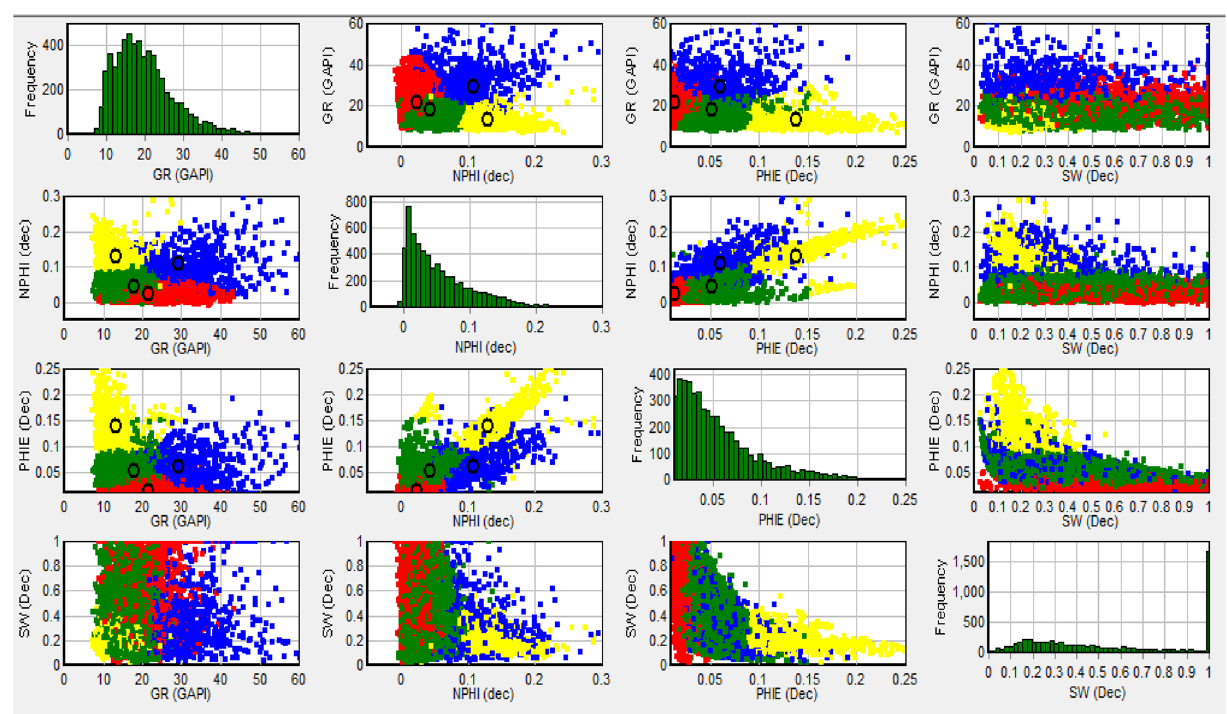
Fig. 16 Final graphical result of clustering